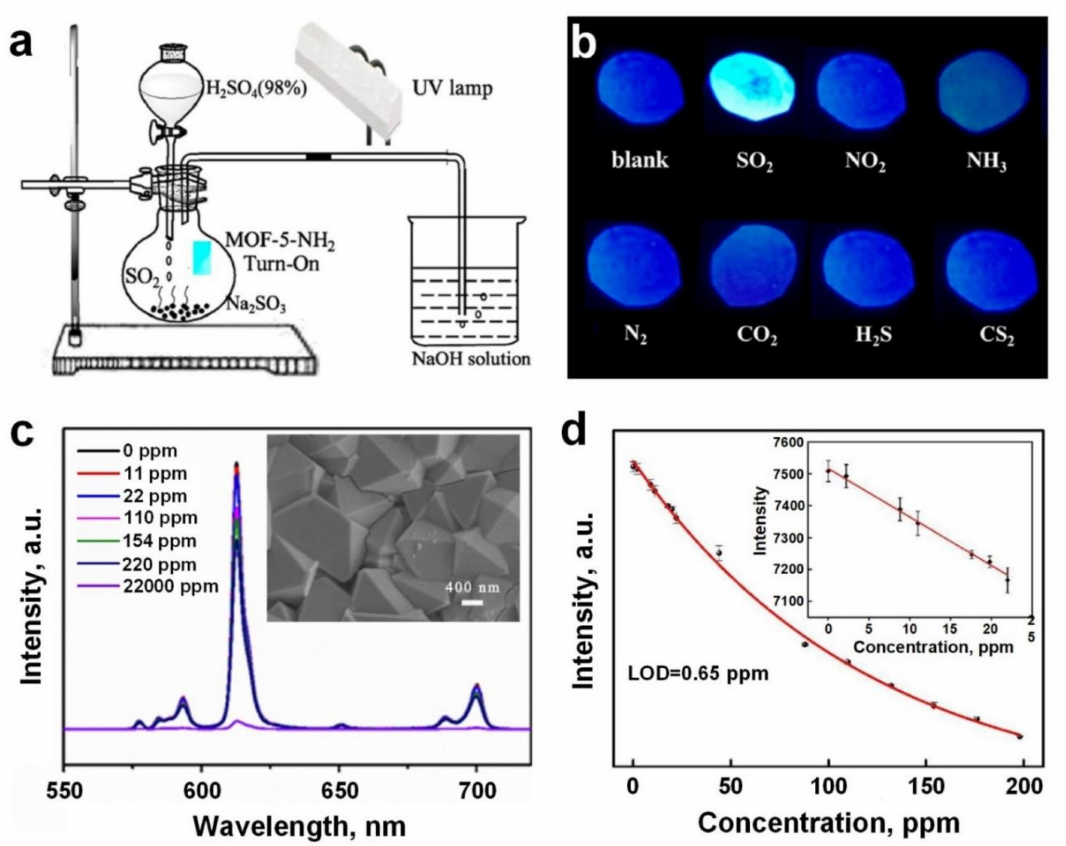
Figure 6. ( a ) Schematic illustration of Kipp’s apparatus used for producing SO 2 gas. ( b ) Photographs of MOF-5-NH 2 luminescent test papers upon exposure to different gases (2 ppm concentration) under a 365 nm UV lamp. Reproduced with permission from [98] American Chemical Society, 2018. ( c ) The emission spectra of Eu-BDC-NH 2 film upon exposure to SO 2 gas at different concentrations, and the SEM image of Eu-BDC-NH 2 film (Inset). ( d ) The relationship of